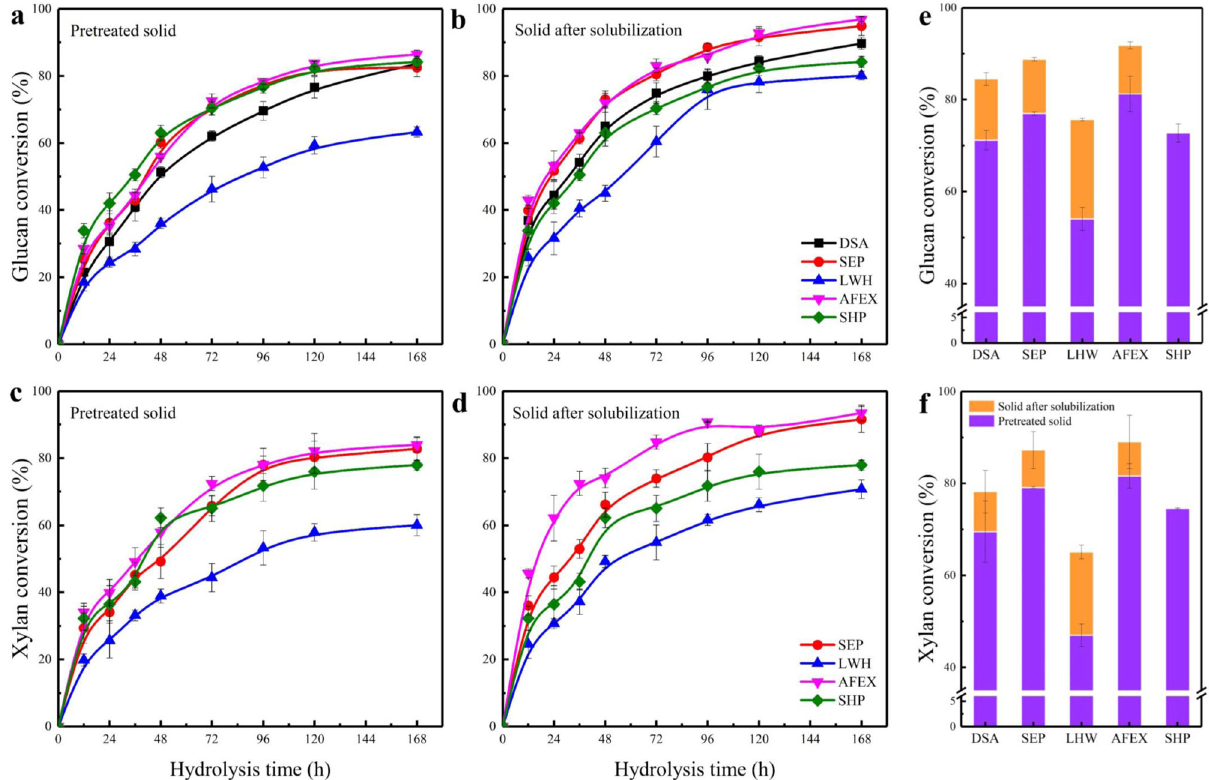
Fig. 3 Enzymatic hydrolysis performance of the carbohydrate solid streams. Kinetics of enzymatic hydrolysis was conducted at 1% solid loading for 168 h ( a – d ). a and b represents the glucan conversion of the solids produced from pretreatment and solubilization, respectively, while c and d represents the xylan conversion of the solids produced from pretreatment and solubilization. High solid enzymatic hydrolysis was conducted at 10% solid loading ( e , f ). e and f represents the glucan and xylan conversion at high solid enzymatic hydrolysis, respectively. DSA dilute sulfuric acid pretreatment, SEP steam explosion pretreatment, LHW liquid hot water pretreatment, AFEX ammonia fi ber expansion, SHP sodium hydroxide pretreatment. Error bars represent the standard deviation.